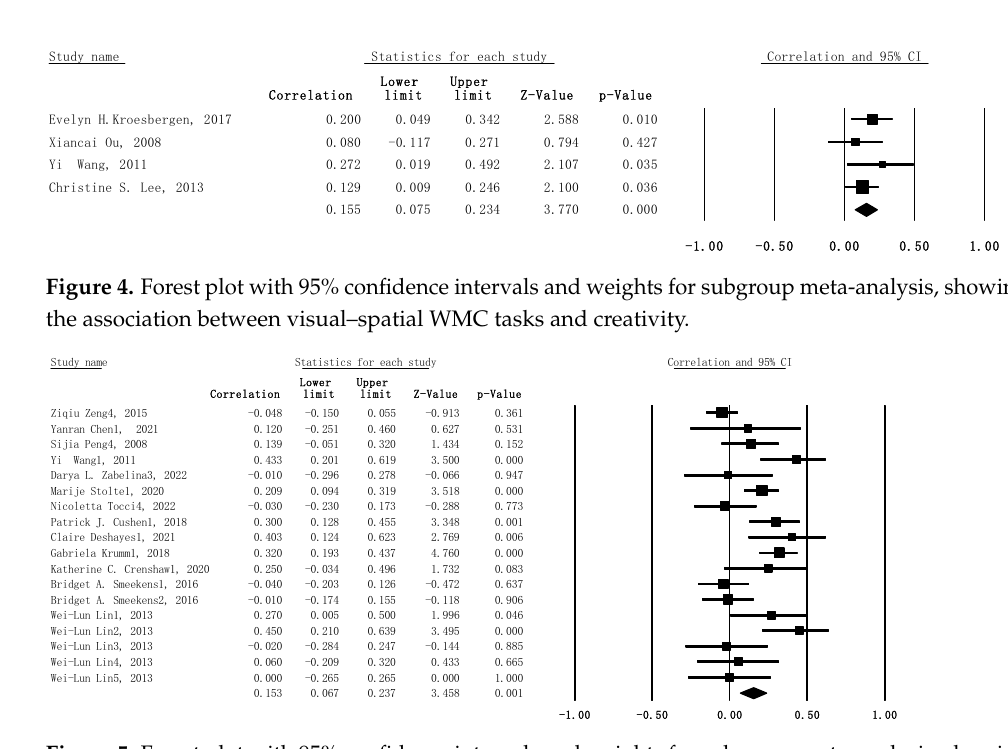
Figure 5. Forest plot with 95% confidence intervals and weights for subgroup meta-analysis, showing the association between dual-tasks and creativity.